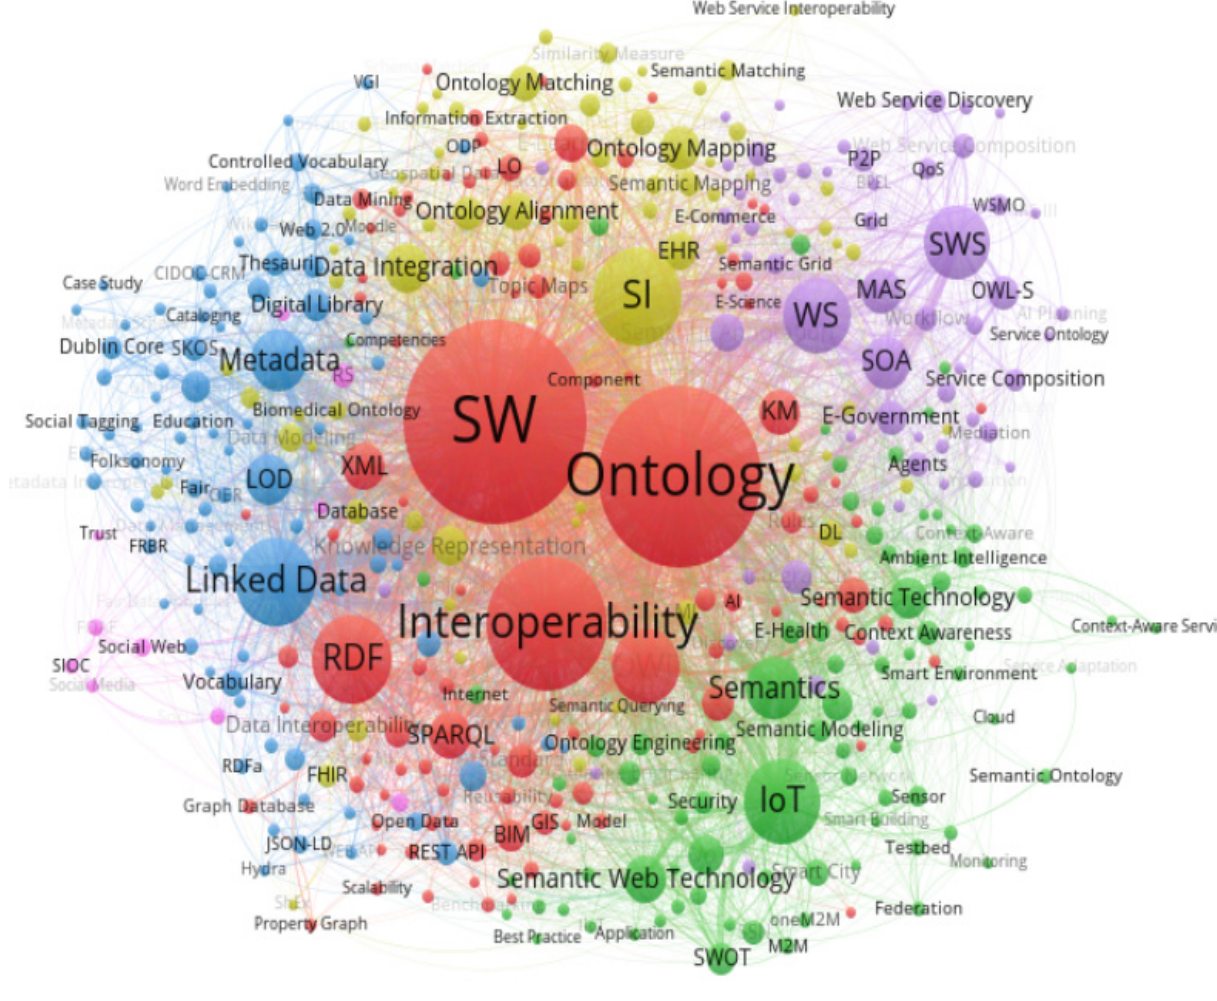
Figure 5. Keyword co-occurrence network.